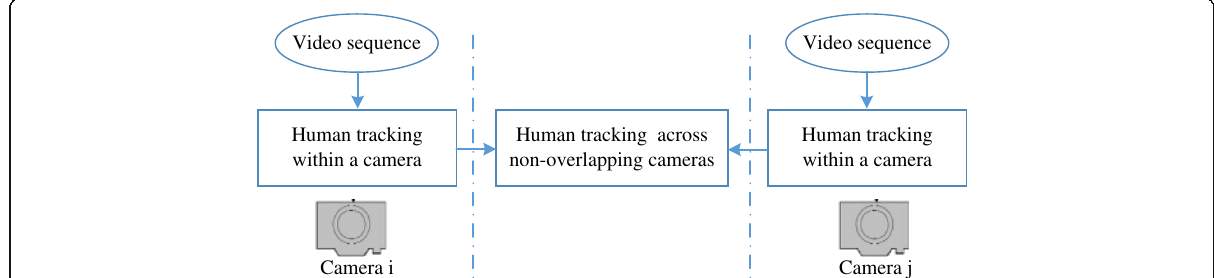
Fig. 3 The inter-relation between functional modules of human tracking over camera